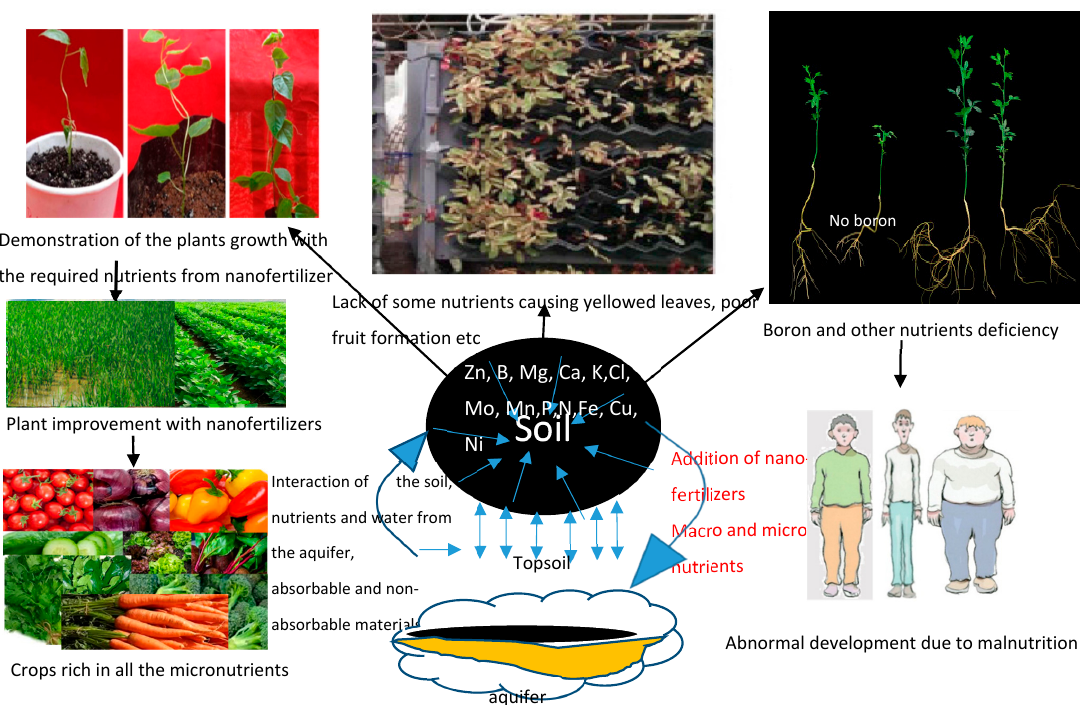
Figure 2. Schematic diagram of influence of micronutrients on crops [Adapted from 137-140].